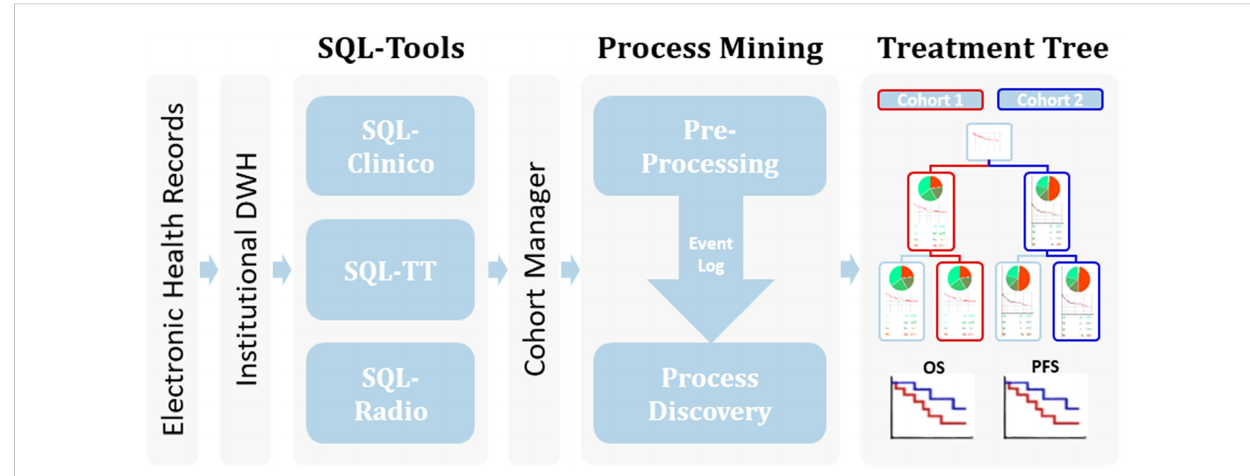
FIGURE 1 Work fl ow of the process mining analysis. Relevant clinical information from the EHR available within an Institutional Data Warehouse (DWH) system was curated in our SQL-Tools that include single-valued clinical data inherent to the patient or the tumor (SQL-Clinico), treatment data (SQL-TT) and radiological or clinical assessments of treatment responses (SQL-Radio). After cohort selection through the Cohort Manager, the associated clinical data was pre-processed to generate an Event Log, which was passed to a process discovery step to produce the interactive Treatment Tree. By using the Treatment Tree interface oncologists can select groups of patients that underwent a speci fi c treatment path and compare their OS and PFS with other groups by simply drag-and-dropping the treatment